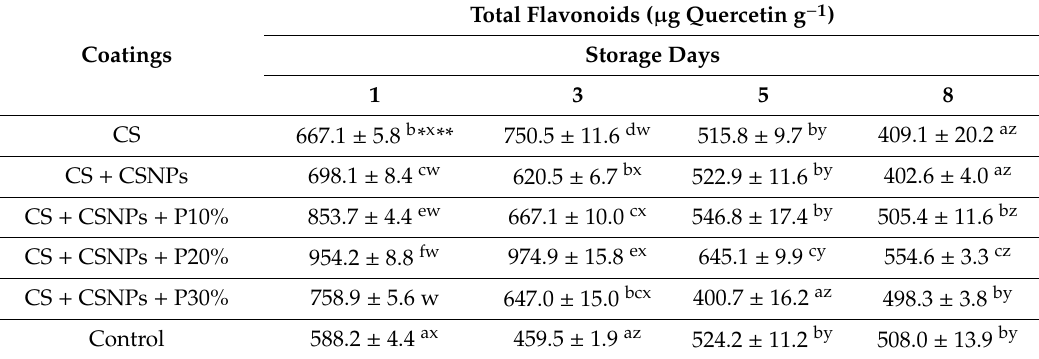
Table 5. Total flavonoid content of strawberry fruit treated with nanostructured chitosan and propolis coatings during eight days of